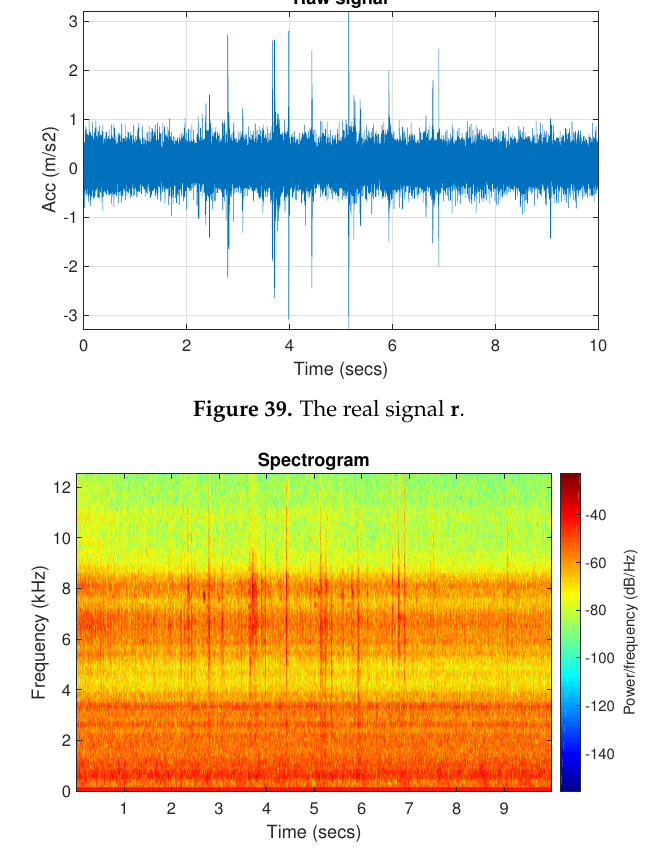
Figure 40. Spectrogram of the real signal r .